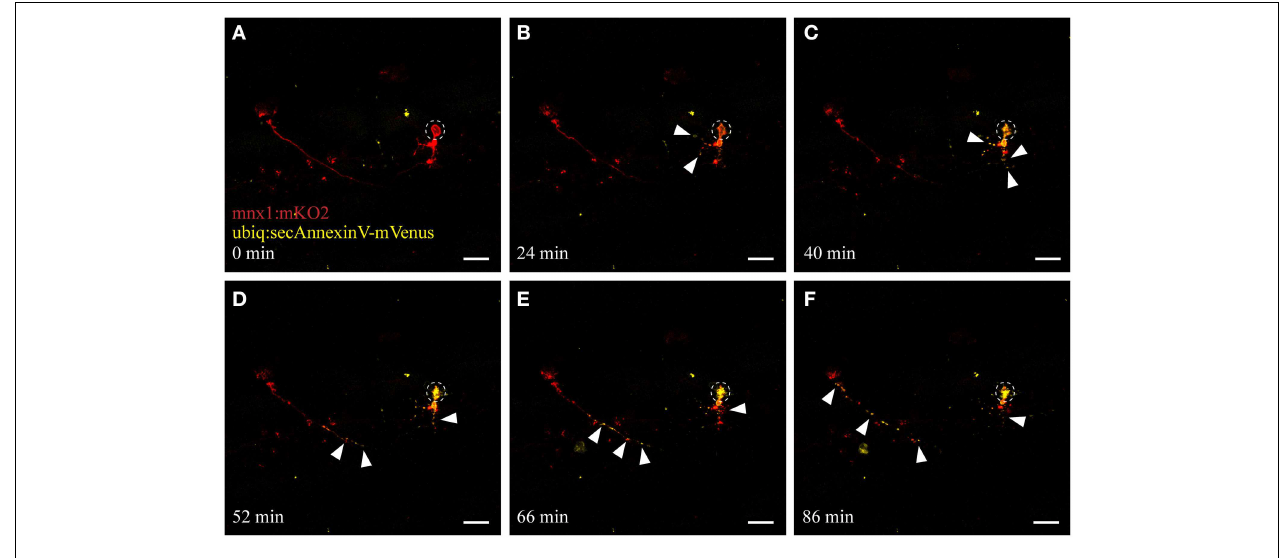
marker indicated by the yellow fluorescence ( B,C , arrowheads). Throughout the time-course of neuronal degeneration, AnnexinV puncta (yellow fluorescence) were present within the degenerating cell body (C,D) as well as along the axon, progressing anterogradely from the site of ablation (D–F) . Scale bars = 20 µ m. Supplementary Video 2 shows the time-lapse video of this process.